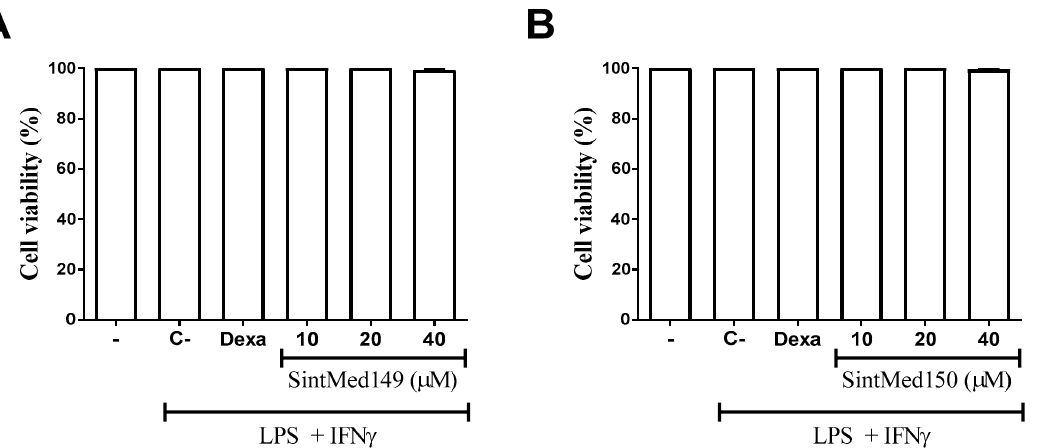
Figure 3. SintMed149 and SintMed150 did not affect peritoneal macrophage viability stimulated with LPS plus IFN γ . Mouse peritoneal exudate macrophages stimulated or not with LPS + IFN γ were cultured in the absence or presence of SintMed149 ( A ) and SintMed150 ( B ) (10, 20, and 40 µ M) or dexamethasone (Dexa; 40 µ M). Cell viability was determined by the Alamar Blue method. “-” refers to the group of untreated and unstimulated cells. C- refers to the group of untreated cells stimulated with LPS + IFN γ . Values represent the mean ( ± standard deviation) of four determinations obtained from three experiments performed.